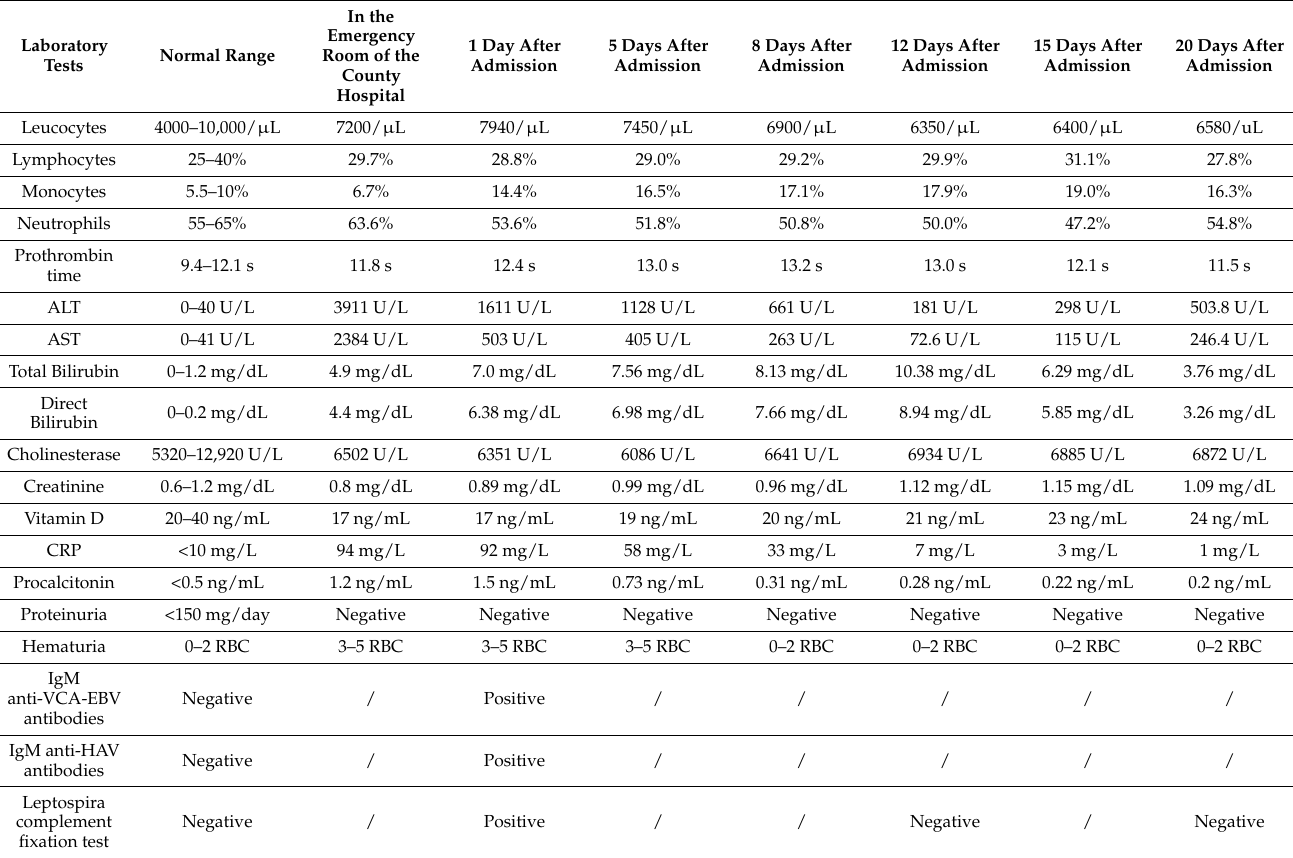
Table 1. Laboratory findings during